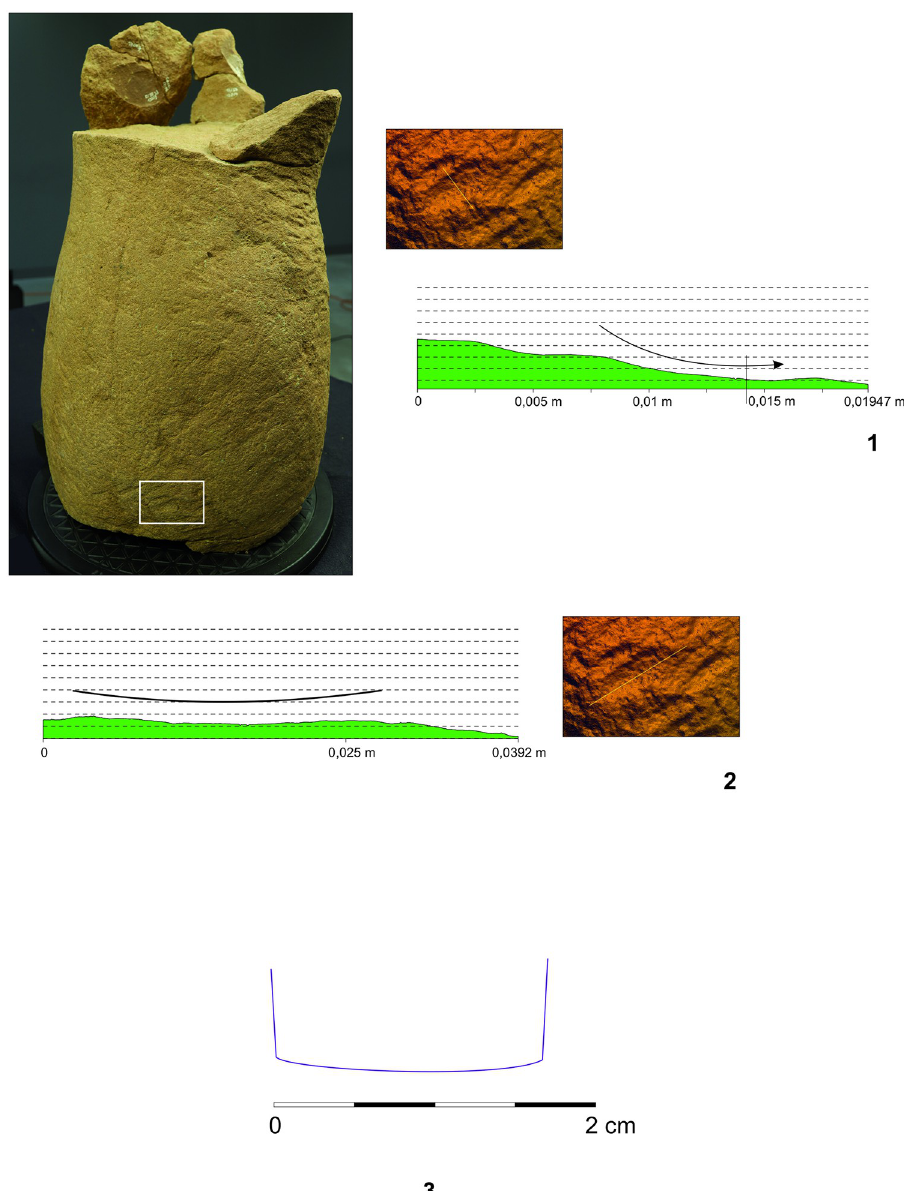
Fig 14. Fragment of a leg of the Statue 2 from Glauberg. 1 longitudinal section of the identified trace on the calf; 2 transverse section of the same trace; 3 reconstruction of the identified blade of the tool as derived from the trace (author: M. Cihla and F. R.